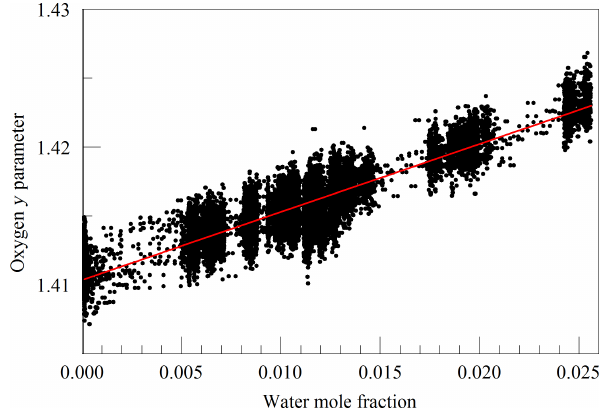
Figure 7. Measured absorption line amplitudes for oxygen and wa- Figure 6. Galatry collisional broadening parameter of the oxygen ter vapor for water vapor mixing ratios ranging from nearly 0 to Q13Q13 line at 340hPa and 45 ◦ C versus the water mole fraction. 0.025. Black points are from measurements and the red line is a Black points are from measurements and the red line is a linear fit linear fit with an intercept of 7 . 78001 × 10 − 6 cm − 1 and a slope of of y = 1 . 4109 + 0 . 467 f H . − 0 . 2 O